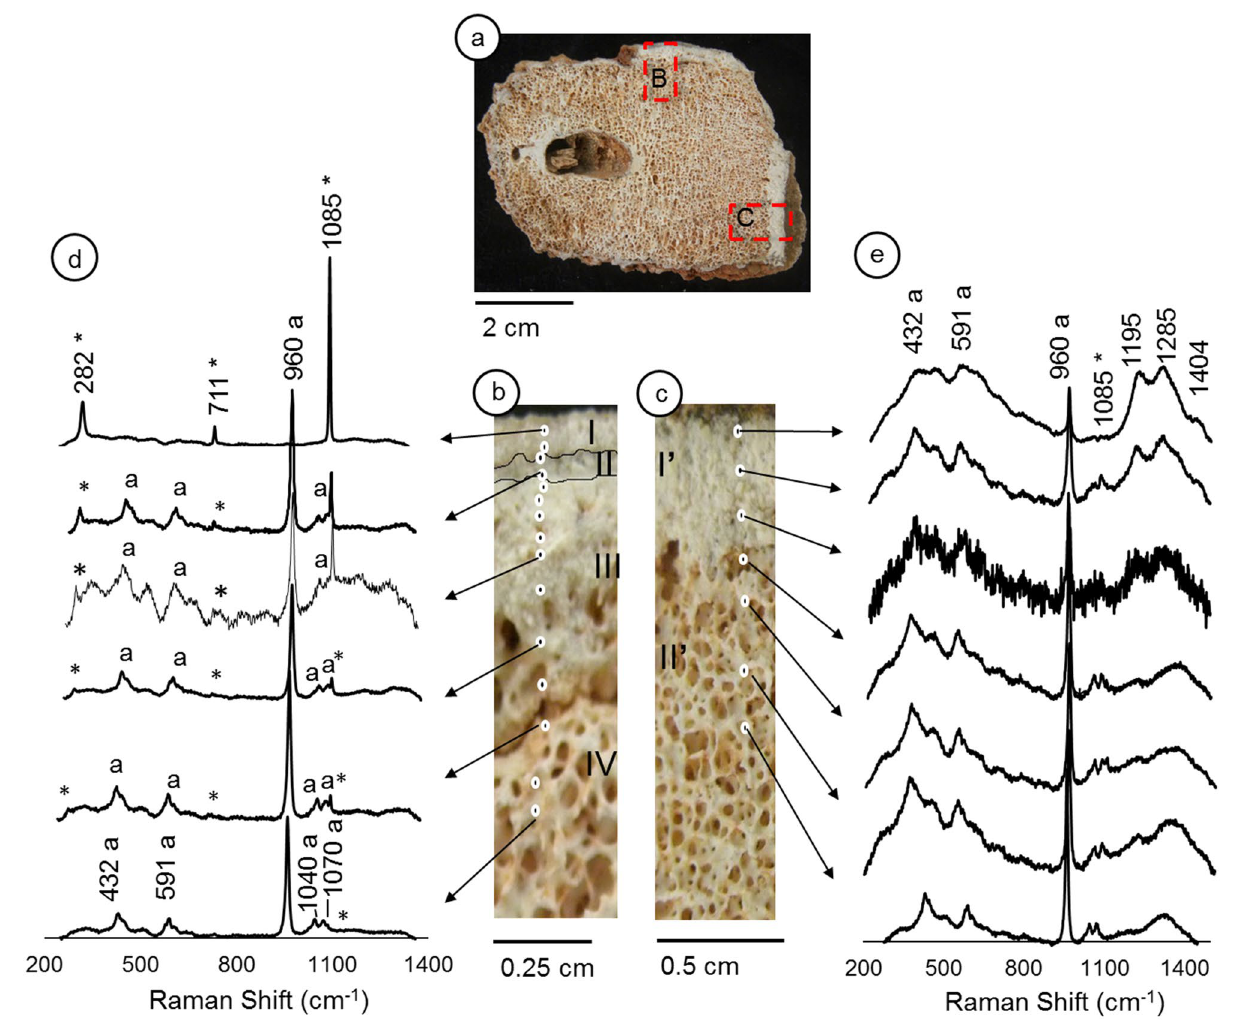
Figure 2. Internal surface of the LAPA/SBF-3-0017 sample. Figure ( a )—shows the selected areas (red dashed boxes B and C) where micro-Raman measurements were carried out. Figures ( b ) and ( c )—Details of red dashed boxes in figure a. Figures ( d ) and ( e )—Raman spectra of each microstratigraphic ‘layer’; ‘*’ indicates the peaks for calcite, and ’a’ refers to